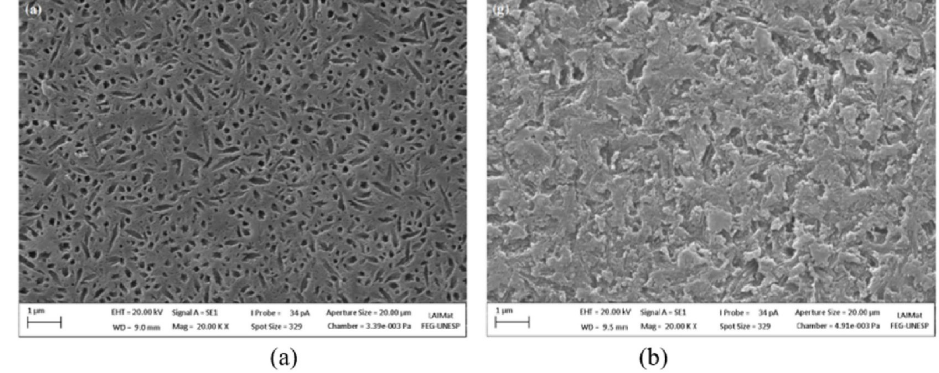
SiO crystals); (b) after 2 3